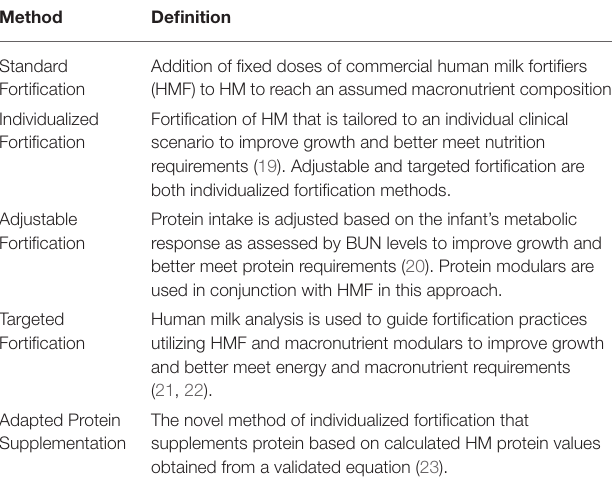
TABLE 4 | Methods of fortification of